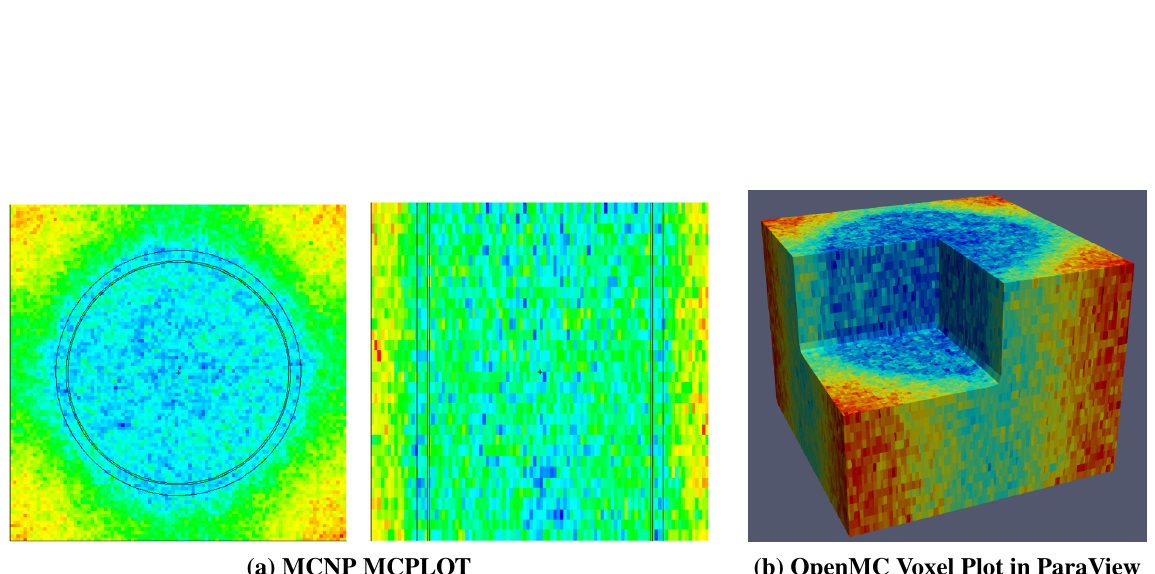
Figure 4: Plotting MESHTAL files from native and OpenMC formats